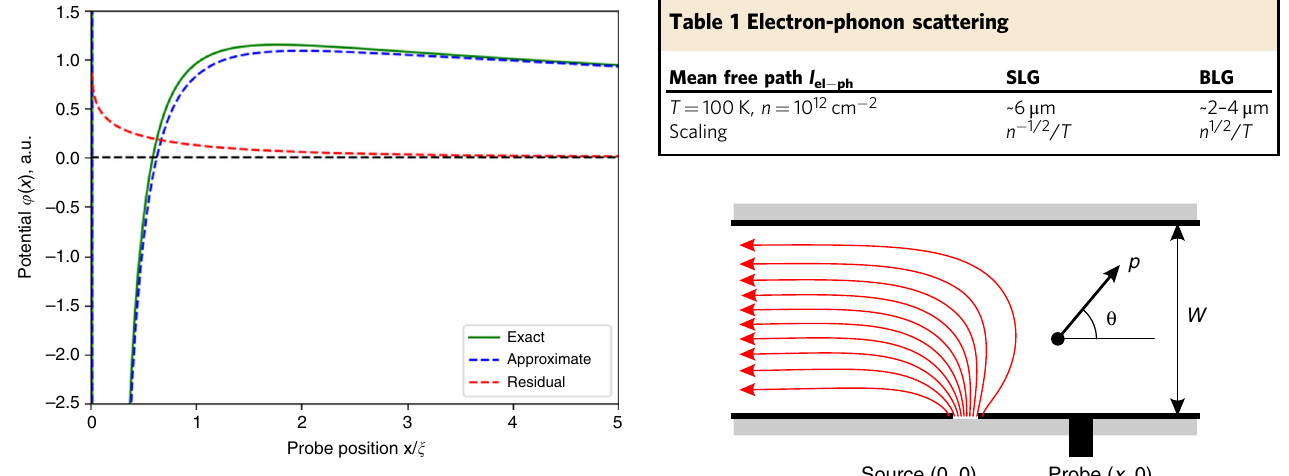
Fig. 4 Potential at the edge of a halfplane as a function of the distance to the current injector, calculated for the no-slip boundary conditions. The exact result (green curve) can be approximated by a direct sum of the Ohmic and viscous contributions (dashed blue curve). The residual (dashed red curve) is the non-additive part, de fi ned as the difference of the exact and approximate potentials. At x (cid:3) ξ the residual constitutes no more than 10 – 15% of the net potential value, becoming much smaller at x (cid:4) ξ and x (cid:2)